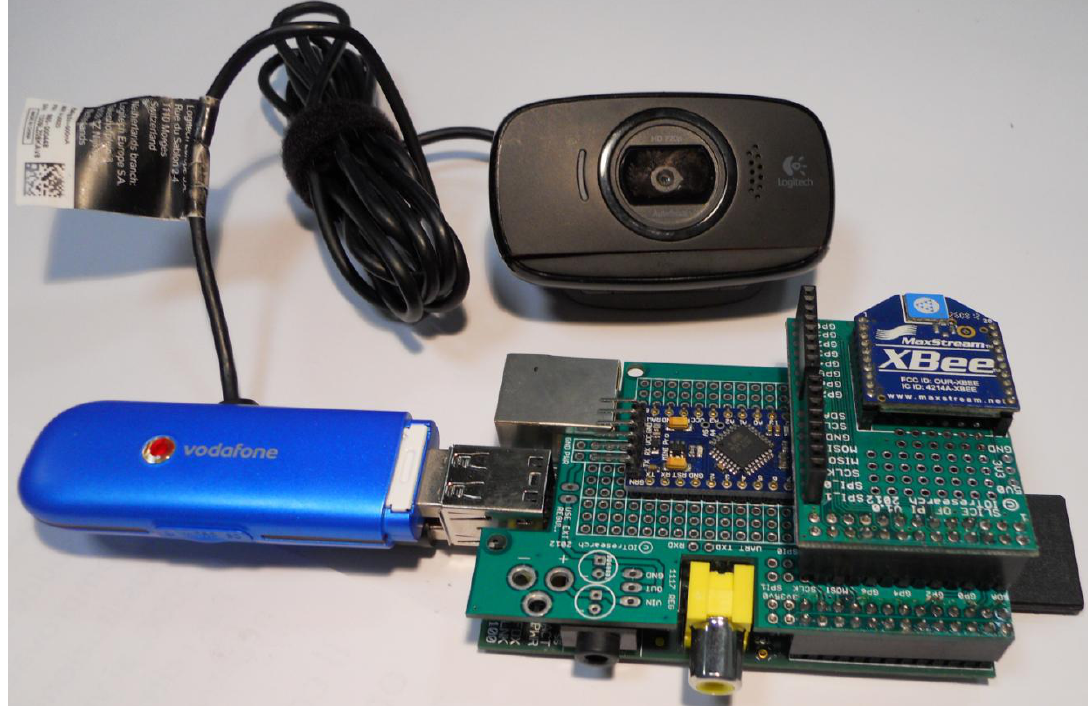
Figure 2. The hub core: Raspberry, ARDUINO with the XBee module and the Camera.